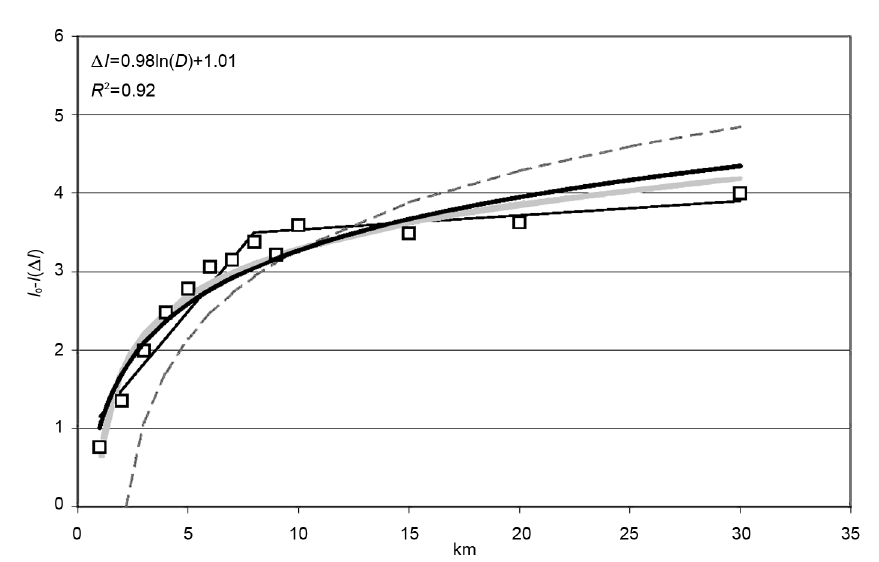
Fig. 8a. Different intensity attenuation relationships for the Etna area: bi-linear (thin line), logarithmic (thick line), Grandori et al . (1987) (grey), Peruzza (2000) (dashed); squares show the arithmetic average of ∆ I in fig.